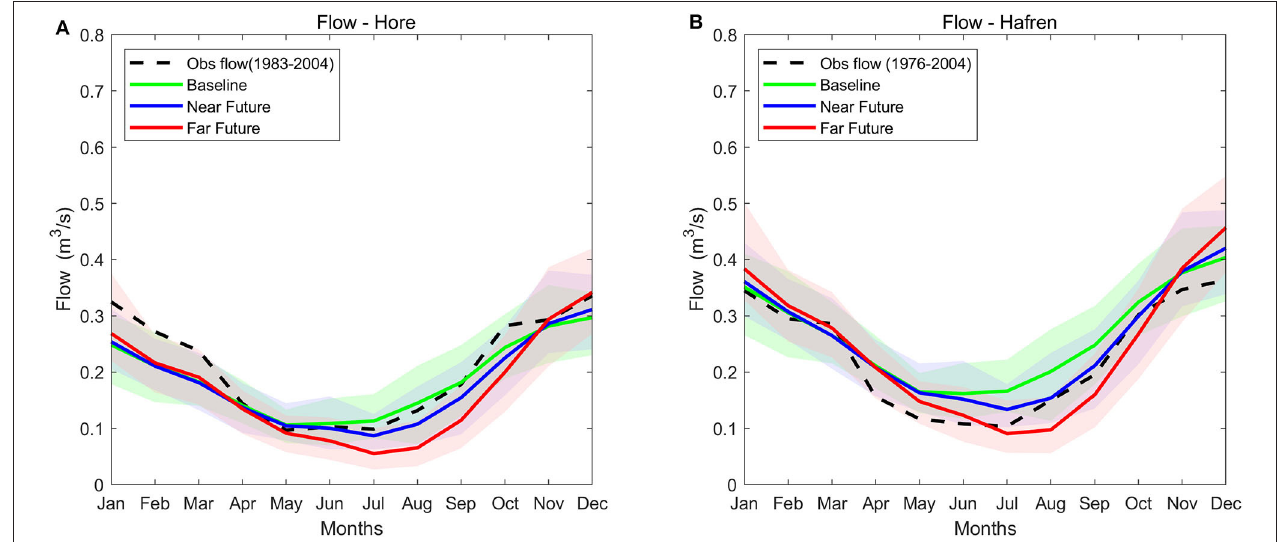
FIGURE 8 | Impact of climate change on flow at Hore (A) and Hafren (B)